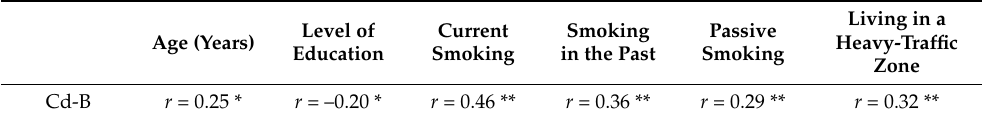
Table 3. Correlations between potential sources of cadmium, basic characteristics of the study population, and Cd-B.